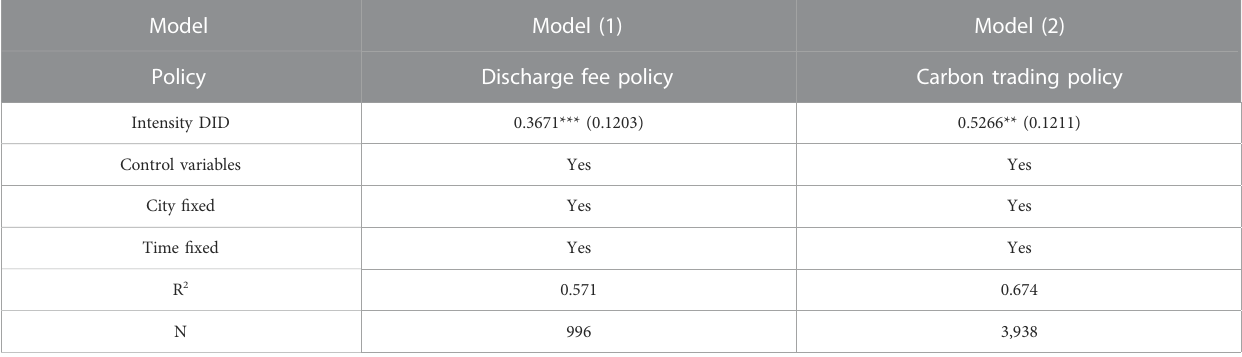
TABLE 7 Policy uniqueness test.